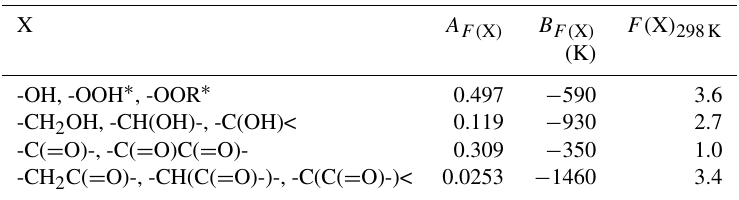
Table 5. Substituent factors, F( X ) , for hydroxy, hydroperoxy, peroxy and carbonyl groups, and their temperature dependences described